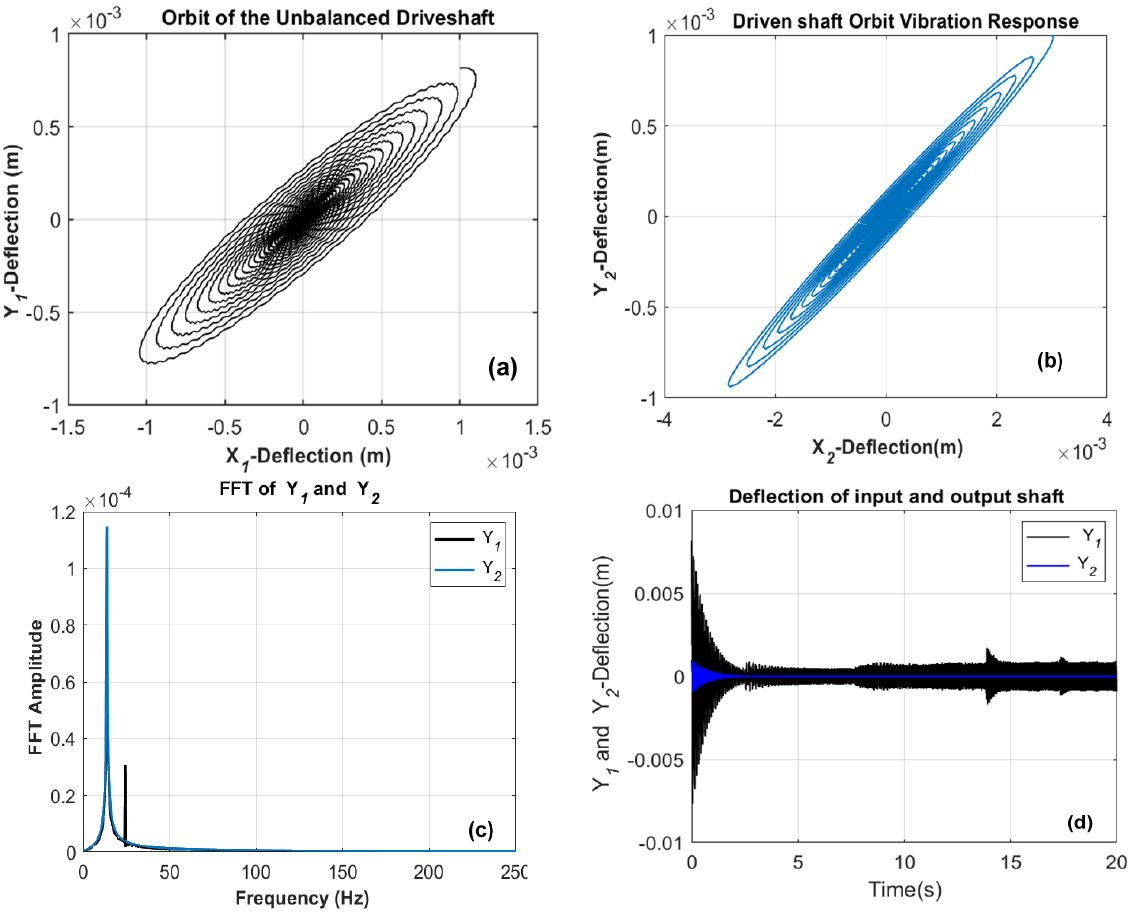
Figure 7. Dynamic response of driveline rotors ( a , b ) displacement orbit of the input and output unbalanced shafts, ( c ) Fast Fourier Transform spectrum response, ( d ) transient time domain response.